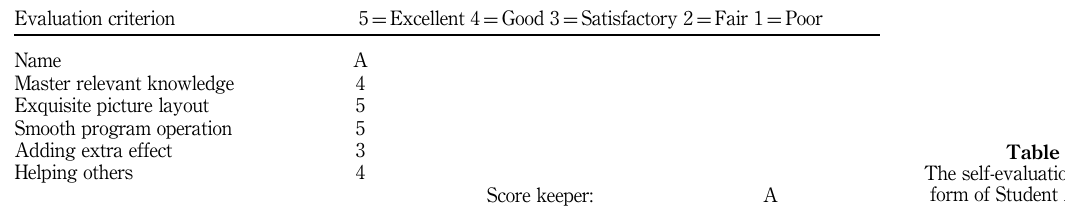
Figure 5. The script blocks